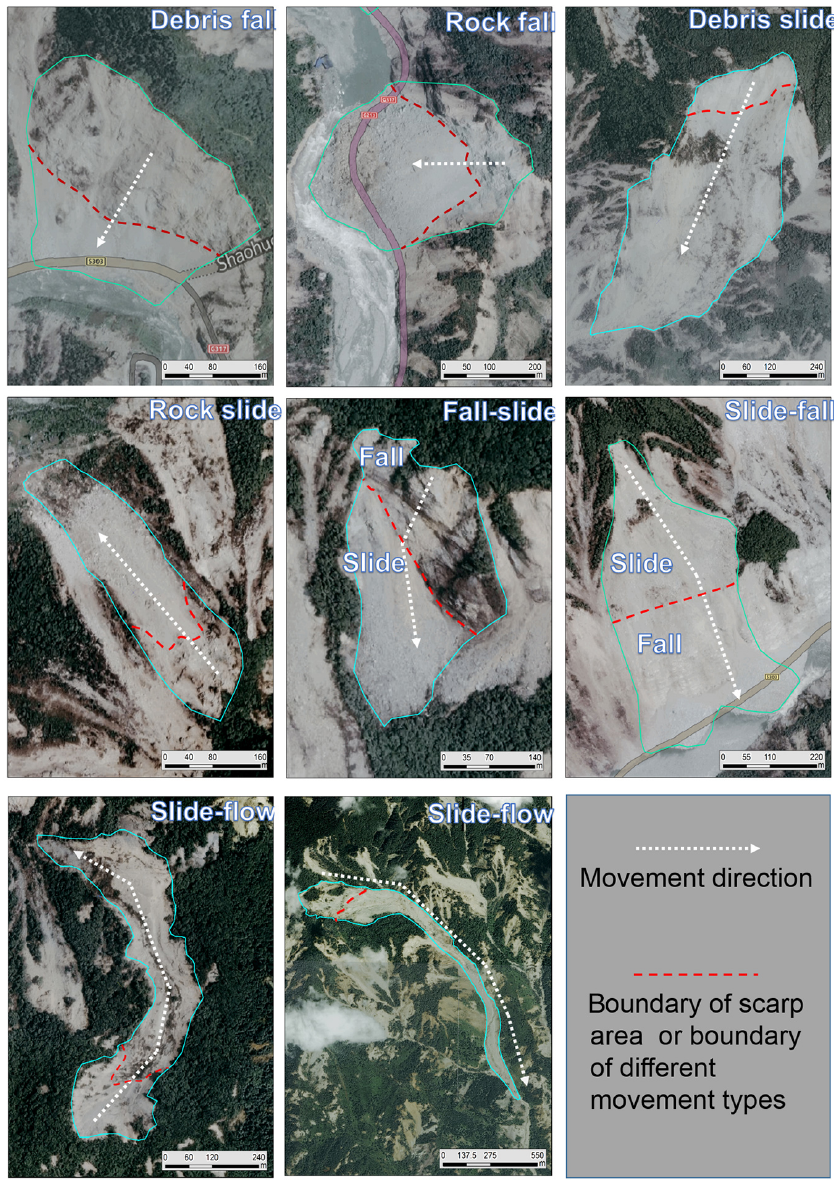
Figure 3. Examples of landslide classifications used. The background is the aerial photo taken in